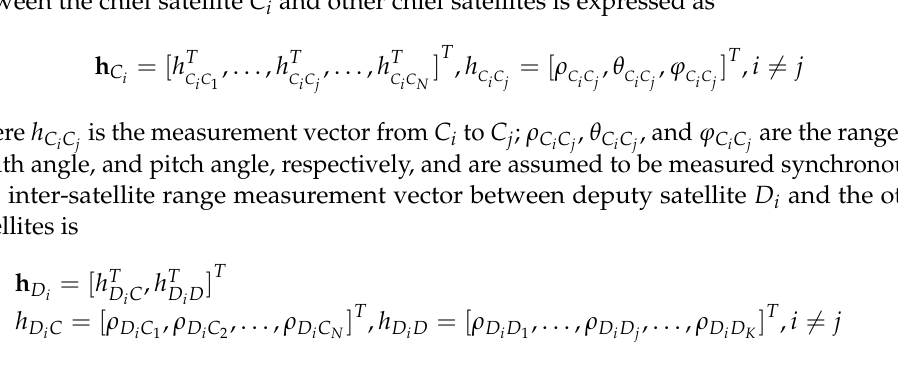
Figure 5. Prototype of RF range measurement equipment for ground testing.